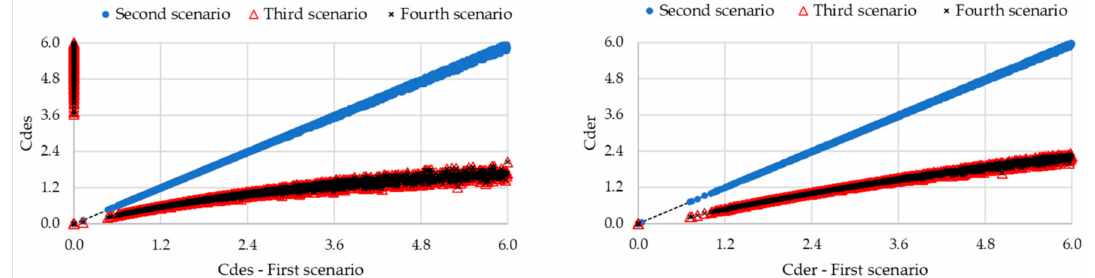
Figure 17. Safety coefficients for the first scenario compared with the second to fourth scenarios—Pedersen et al. (1996).